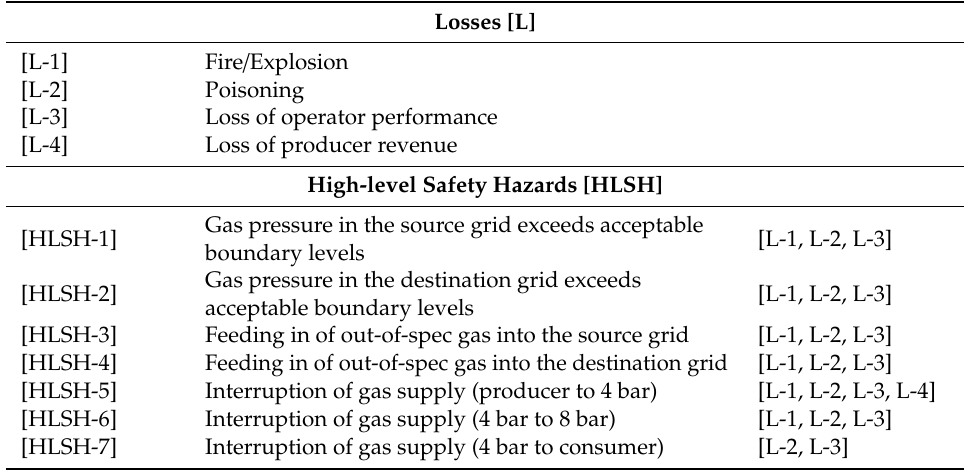
Table 5. High-level Safety Hazards to be considered.